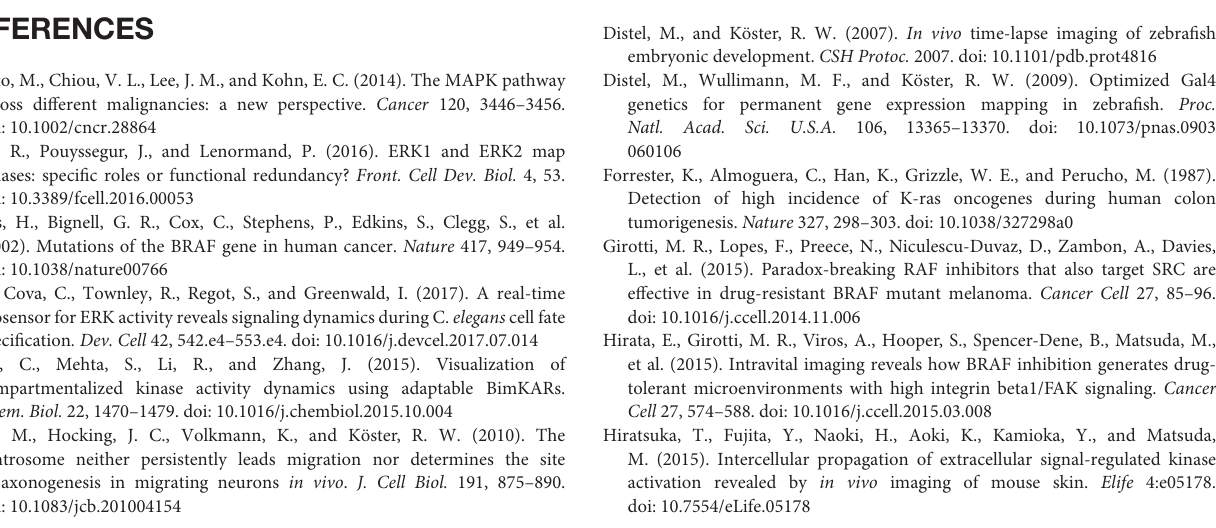
Figure S3 | Effects of different inhibitors on Erk activity in DREKA zebrafish. Compounds were applied to F2 DREKA embryos at 29 hpf and quantification was performed on skin epithelial cells at 48 hpf. Percentage of cells with active Erk signaling shown as box plot from left to right: untreated control; ERK1/2 inhibitor: ulixertinib (1 µ M); MEK1/2 inhibitor: trametinib (10 µ M), PD0325901 (5 µ M); B-RAF inhibitor: vemurafenib (10 µ M); [each dot represents one embryo; box plot was created using R (r-project.org)]. Figure S4 | Effects of nuclear export inhibition by leptomycin B. 26 hpf DREKA zebrafish larvae were treated with the nuclear export inhibiting compound leptomycin B at 92 µ M for 24h. (A,C,E) Treated DREKA, (B,D,F) untreated control DREKA. Muscle cells (A,B) , neural cells in the hindbrain (C,D) , and cranial ganglion cells (E,F) all show increased reporter signal in the nucleus in treated embryos compared to untreated siblings. Scale bars in (A,B,D) are 50 µ m, in (C,E,F) 25 µ m. Images were recorded on a Leica Sp8 X WLL confocal system using a 25x objective. Images were rendered using Adobe Photoshop CS6. Movie 1 | DREKA reveal dynamic Erk signaling in skin epithelial cells during development. Time-lapse movie of transiently ERK-KTR-Clover (green) expressing zebrafish embryos from ∼ 48 to 54 hpf. Dynamic Erk activity can be observed as nuclear cytoplasmic shuttling of mClover in skin epithelial cells (see arrow). Z-stack